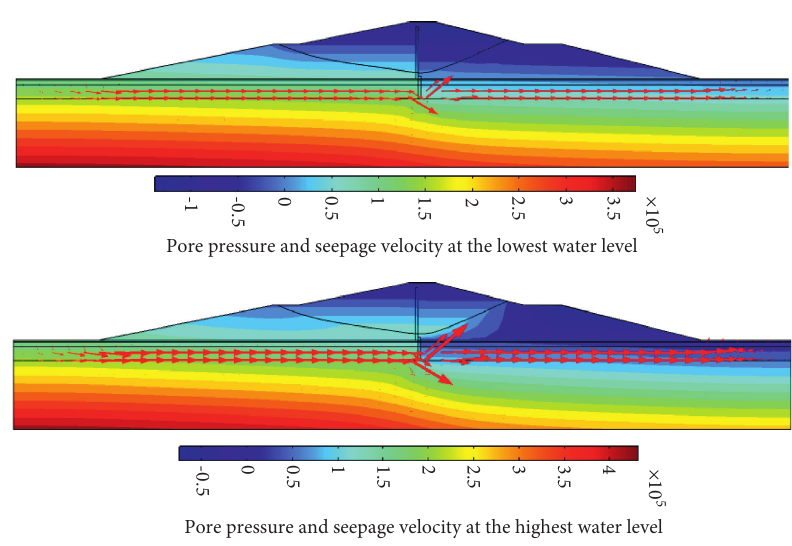
Figure 5: Contour map of pore pressure and seepage velocity in the